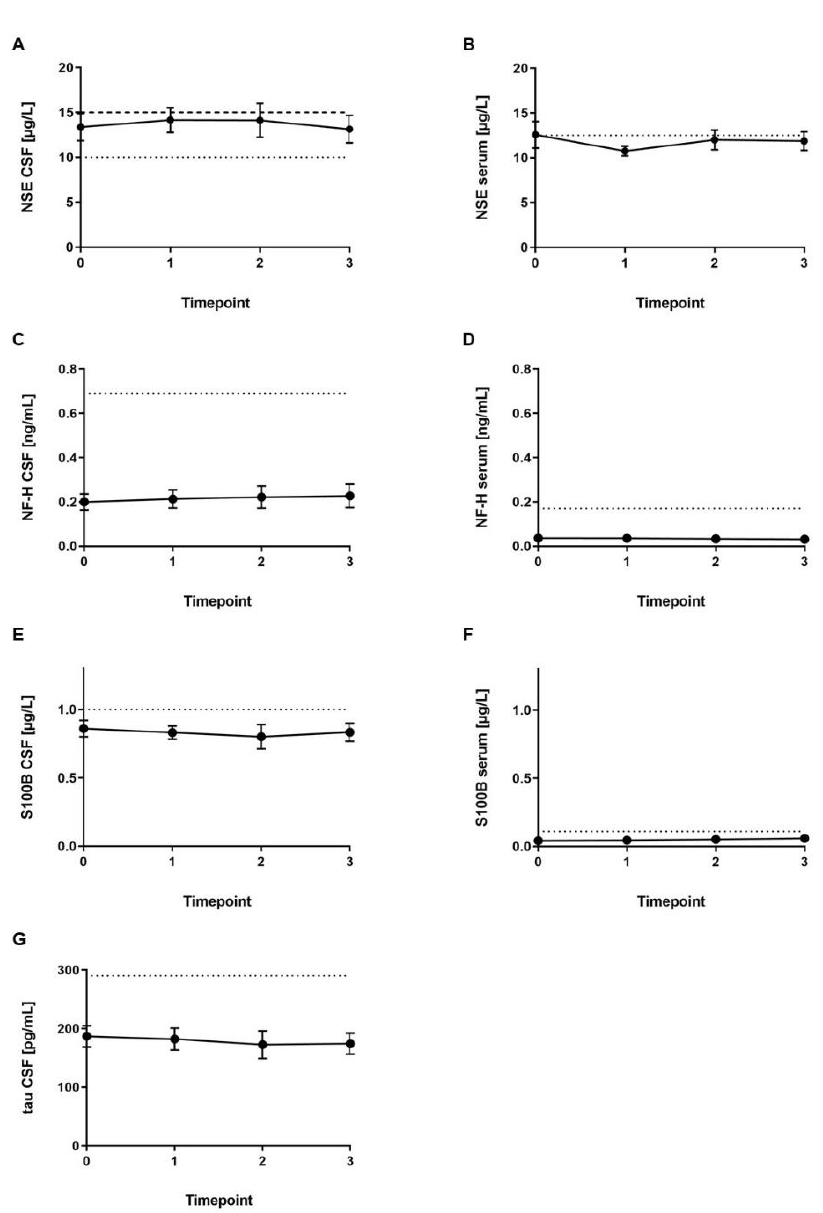
Figure 2. Mean levels ( ± SEM) of biomarkers measured at four timepoints during loading with nusinersen. ( A ) Neuron-specific enolase (NSE) in cerebrospinal fluid (CSF), ( B ) NSE in serum, ( C ) neurofilament heavy chain (NF-H) in CSF, ( D ) NF-H in serum, ( E ) S100B protein (S100B) in CSF, ( F ) S100B in serum, ( G ) tau protein in CSF. Timepoint 0 = before first administration, timepoint 1 = 14 days after first administration and before second, timepoint 2 = 14 days after second administration and before third, timepoint 3 = 30 days after third administration and before fourth. Reference range is indicated by dotted lines. Reference range for NSE in the CSF for ≤45 years of age (<10 µg/L) is indicated by dotted lines, and reference range for >45 years of age (<15 µg/L) is indicated by dashed lines.